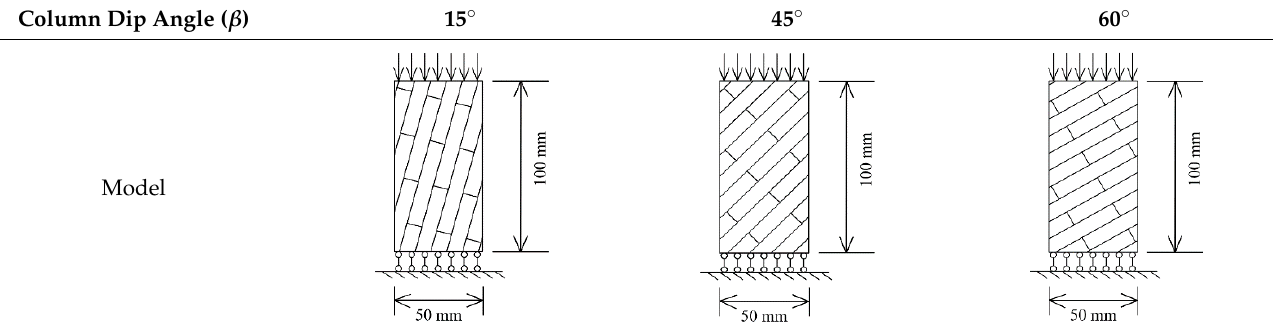
Table 1. The model geometry and load conditions used for verification.